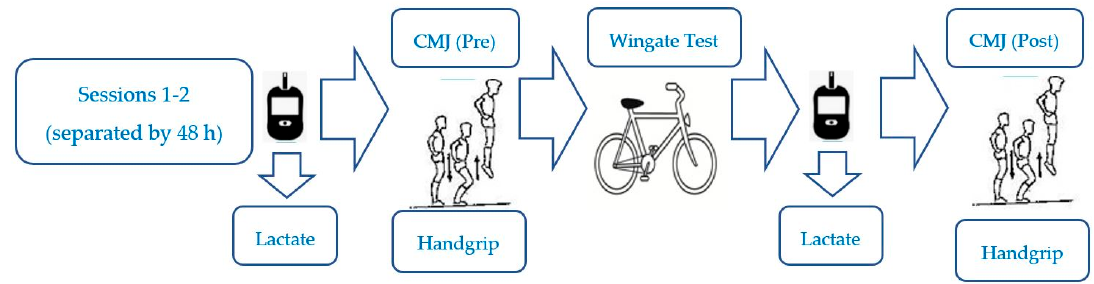
Figure 1. Experimental design. CMJ = countermovement jump test.